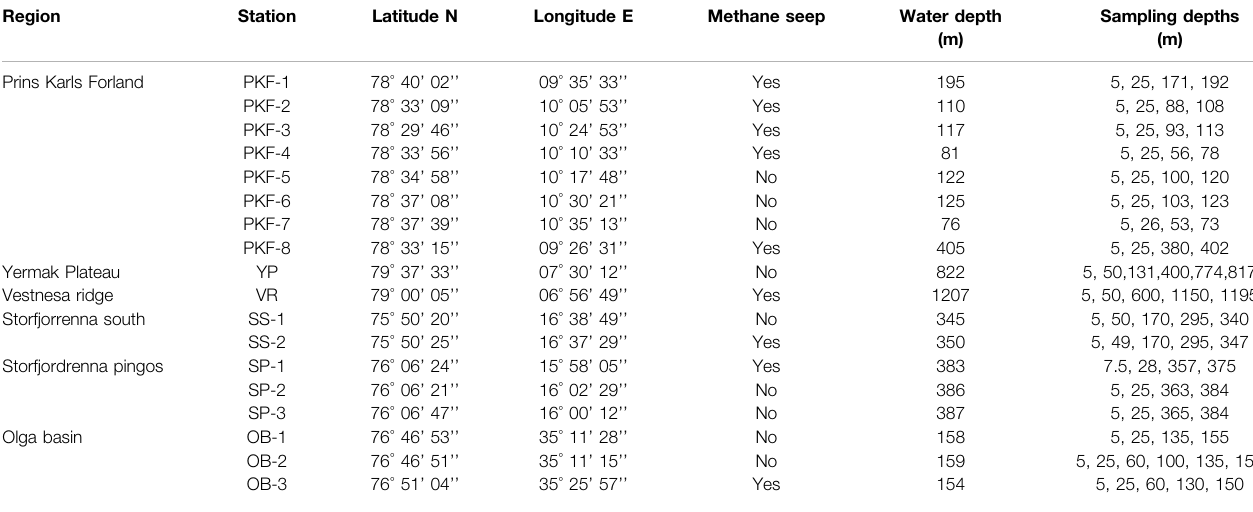
TABLE 1 | Detailed information of the sampled stations listing sample regions, sampling stations, station location, methane seep characteristic, water depth, and sampling depth of water samples. Region Station Latitude N Longitude E Methane seep Water depth